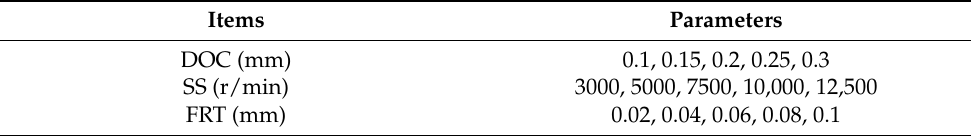
Table 3. Parameters for the milling